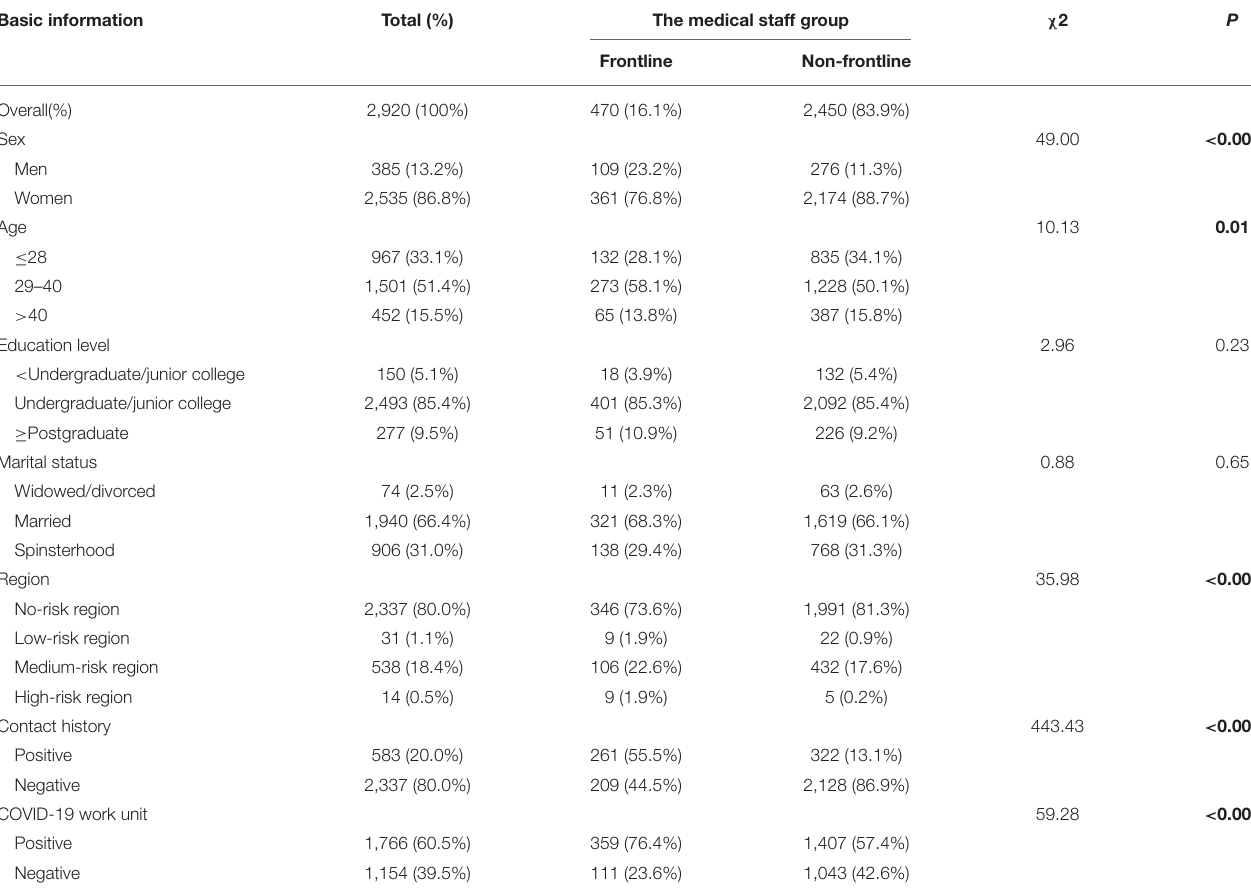
TABLE 1 | Comparison of basic information between frontline and non-frontline medical